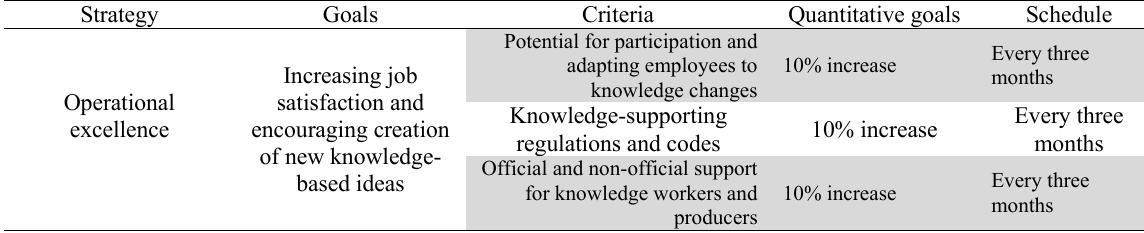
BSC for the staff satisfaction dimension in knowledge management evaluation in petrochemical industries